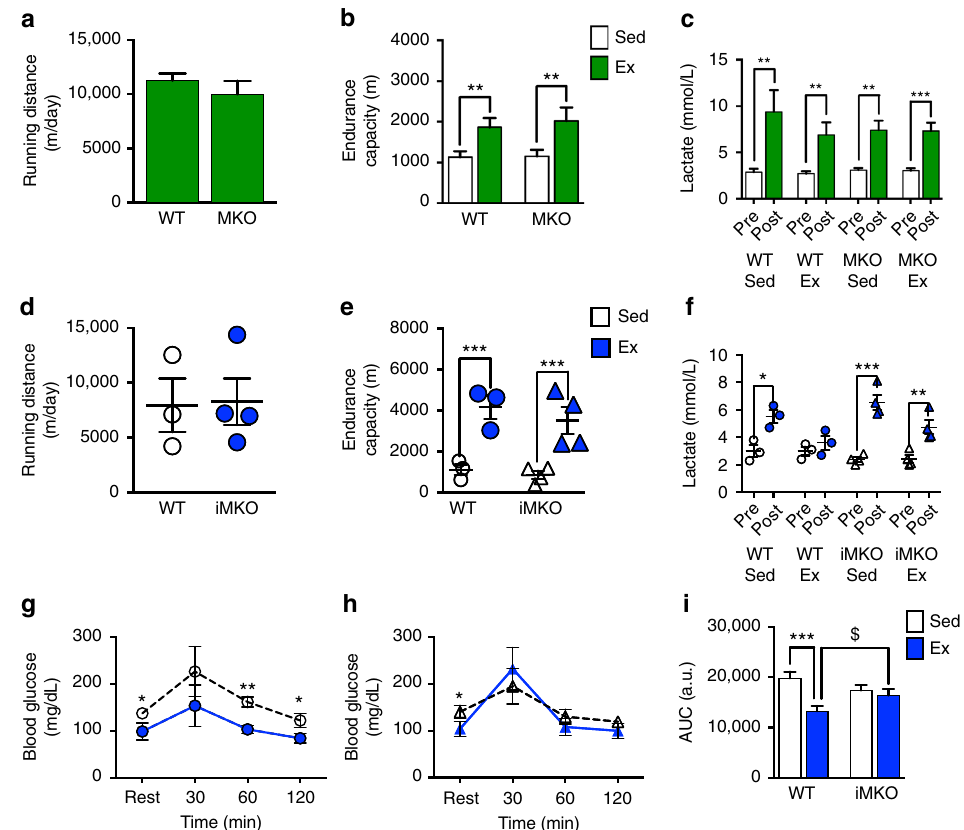
Fig. 7 Ulk1 in skeletal muscle is important for exercise training-induced metabolic adaptation. MKO and iMKO mice displayed normal adaptation to exercise training as assessed by daily running distance a , d , exhaustive exercise test b , e and blood lactate levels c , f . WT mice exhibited improved glucose tolerance following 4 weeks of exercise training as assessed by blood glucose pro fi le during GTT g and AUC i . In contrast, iMKO mice failed to show improved glucose tolerance following exercise training during GTT h and AUC i . Data presented as mean ± standard error of the mean. For MKO study n = 7 – 8 WT and n = 6 – 7 MKO (12 – 13 weeks). Two-tailed t -tests were used for (A: t = 0.84 and DF = 9) and (C: WT Sed t = 3.73 and DF = 12, WT Ex t = 2.97 and DF = 14, MKO Sed t = 6.35 and DF = 10, MKO Ex t = 5.25, DF = 12). Lactate data c was 1/Y transformed to account for unequal variance. A two-way ANOVA was used for b with ** p < 0.01 for sedentary vs. exercise comparison, F = 11.50, DF = 1. For iMKO study n = 3 WT and n = 4 iMKO (18 – 20 weeks). Two-tailed t -tests were used for (D: t = 0.10 and DF = 5), (F: WT Sed t = 3.98, DF = 4), (F: WT Ex t = 0.98, DF = 4), (F: iMKO Sed t = 7.35, DF = 6), and (F: iMKO Ex t = 3.99, DF = 6). A two-way ANOVA was used for e , i with *** p < 0.001, F = 35.16, and DF = 1 for sedentary vs. exercise comparisons. Tukey multiple comparison test was performed for the signi fi cant interaction effect in i , in which *** p < 0.001 for WT sedentary vs. WT exercise comparisons and $ p < 0.05 for WT exercise vs. iMKO exercise comparisons, DF =